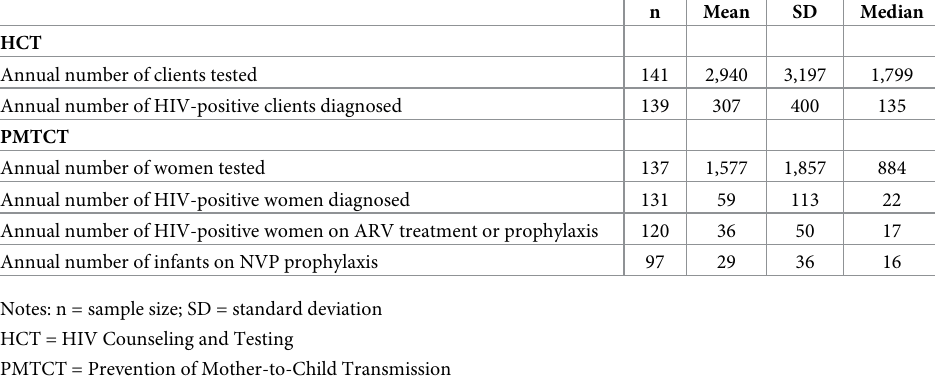
Table 2. Average number of clients per facility along the HCT and PMTCT service cascades.